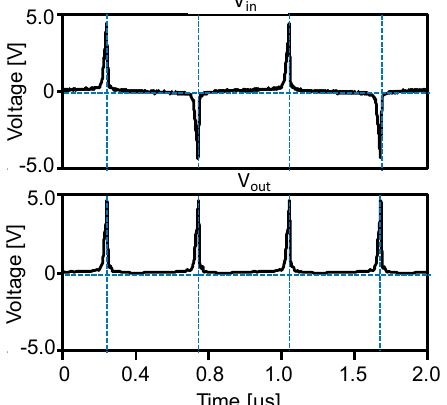
Figure 10. Waveforms of intrinsic pulse voltage, V in , from the Wiegand sensor calculated using MATLAB/Simulink (top), and output voltage across load resistor R = 10 k Ω , V out , calculated using LTspice (bottom).